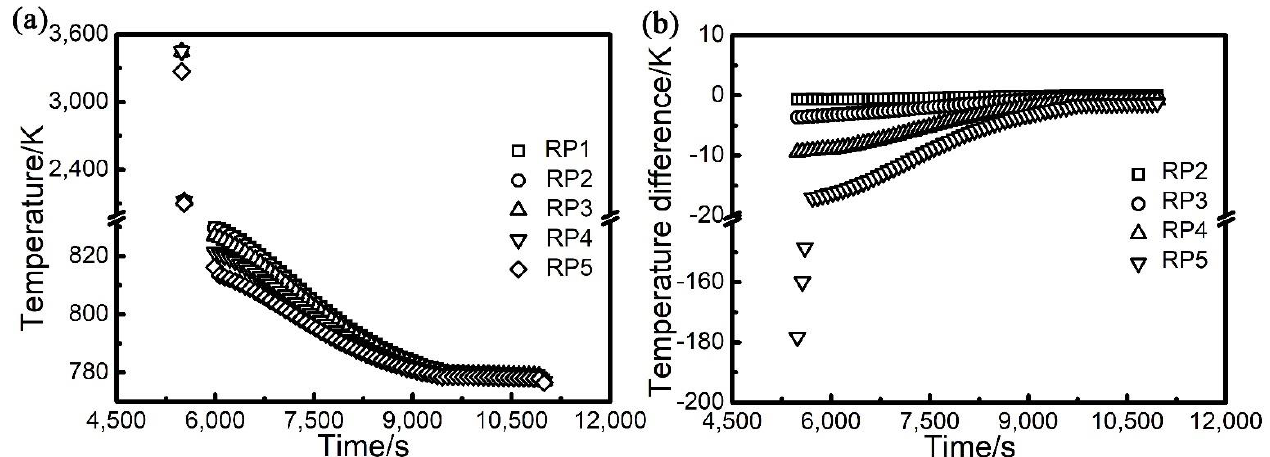
Figure 6. Evolution of peak temperature ( a ) and temperature difference ( b ) with time at different radial sampling points along the radial direction of the studied sample shown in Figure 1.